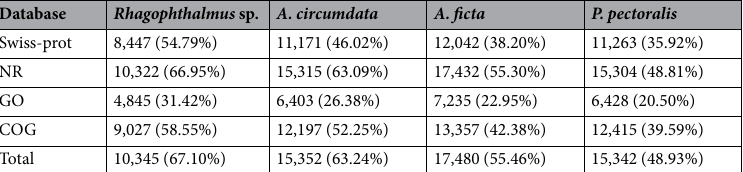
Table 2. Summary of unigene annotations for the four transcriptomes. Percentages of all unigenes in a given species were shown in parentheses. Abbreviations: NR, NCBI non-redundant proteins; COG, Clusters of Orthologous Groups of proteins; GO, Gene Ontology.